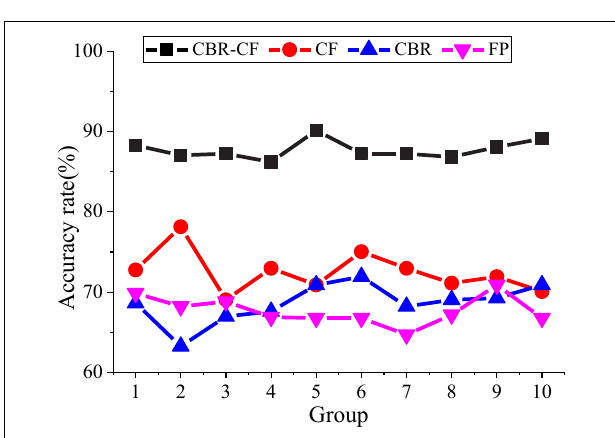
FIGURE 10 | Analysis of the accuracy of the text-similarity calculation of the hybrid